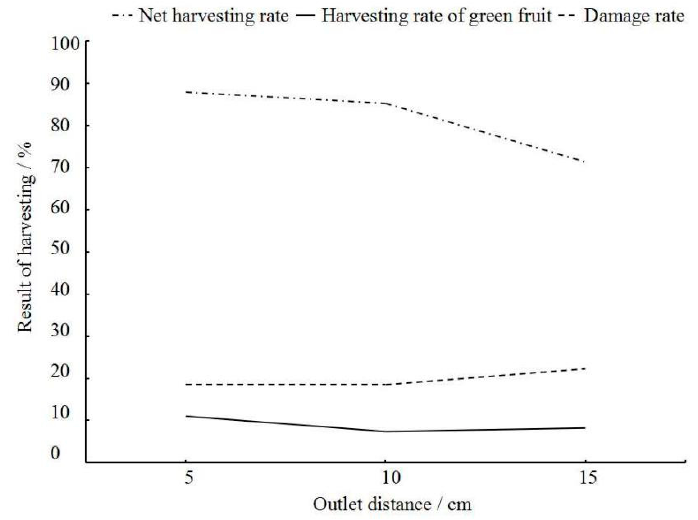
Figure 10. Effects of outlet distance on different parameters.